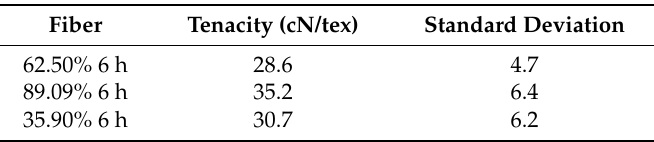
Table 5. Tenacity of the different fibers treated in the last